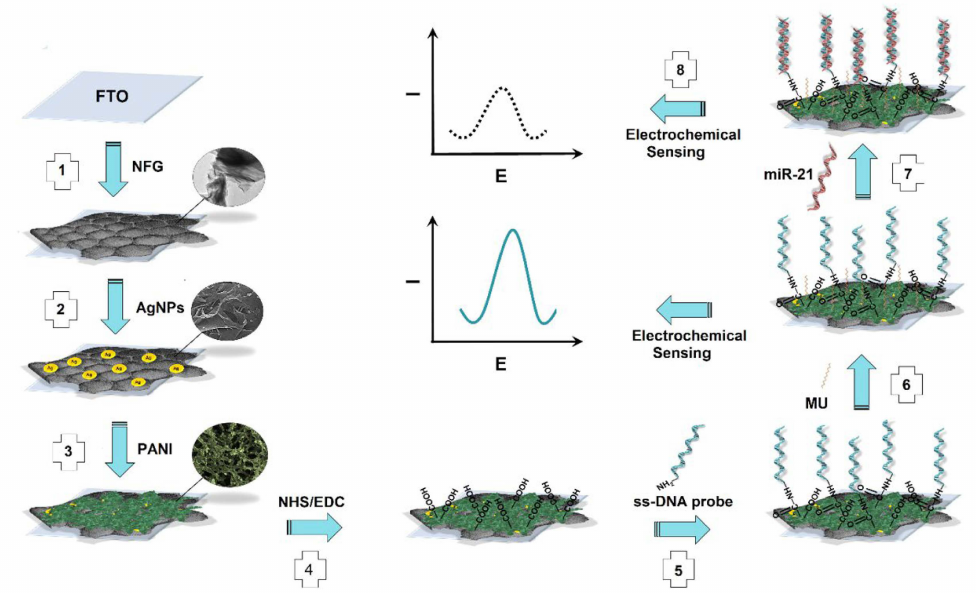
Figure 17. The schematic illustration of sensor fabrication; (1) Preparation of N-doped func- tionalized graphene (NFG)-modified fluorine-doped tin oxide (FTO) electrode. (2) Modification of silver nanoparticles and (3) PANI by electrodeposition. (4) Surface functionalization by us- ing N-hydroxysuccinimide (NHS)/1-Ethyl-3-(3-dimethylaminopropyl) carbodiimide hydrochloride (EDC). (5) Immobilization of probe DNA. (6) Surface blocking process with 11-mercapto-1-undecanol (MU). (7) Hybridization with miRNA-21 target. (8) Measurement with differential pulse voltammetry (DPV) technique. Reprinted with permission Ref. [119]. Copyright 2018,